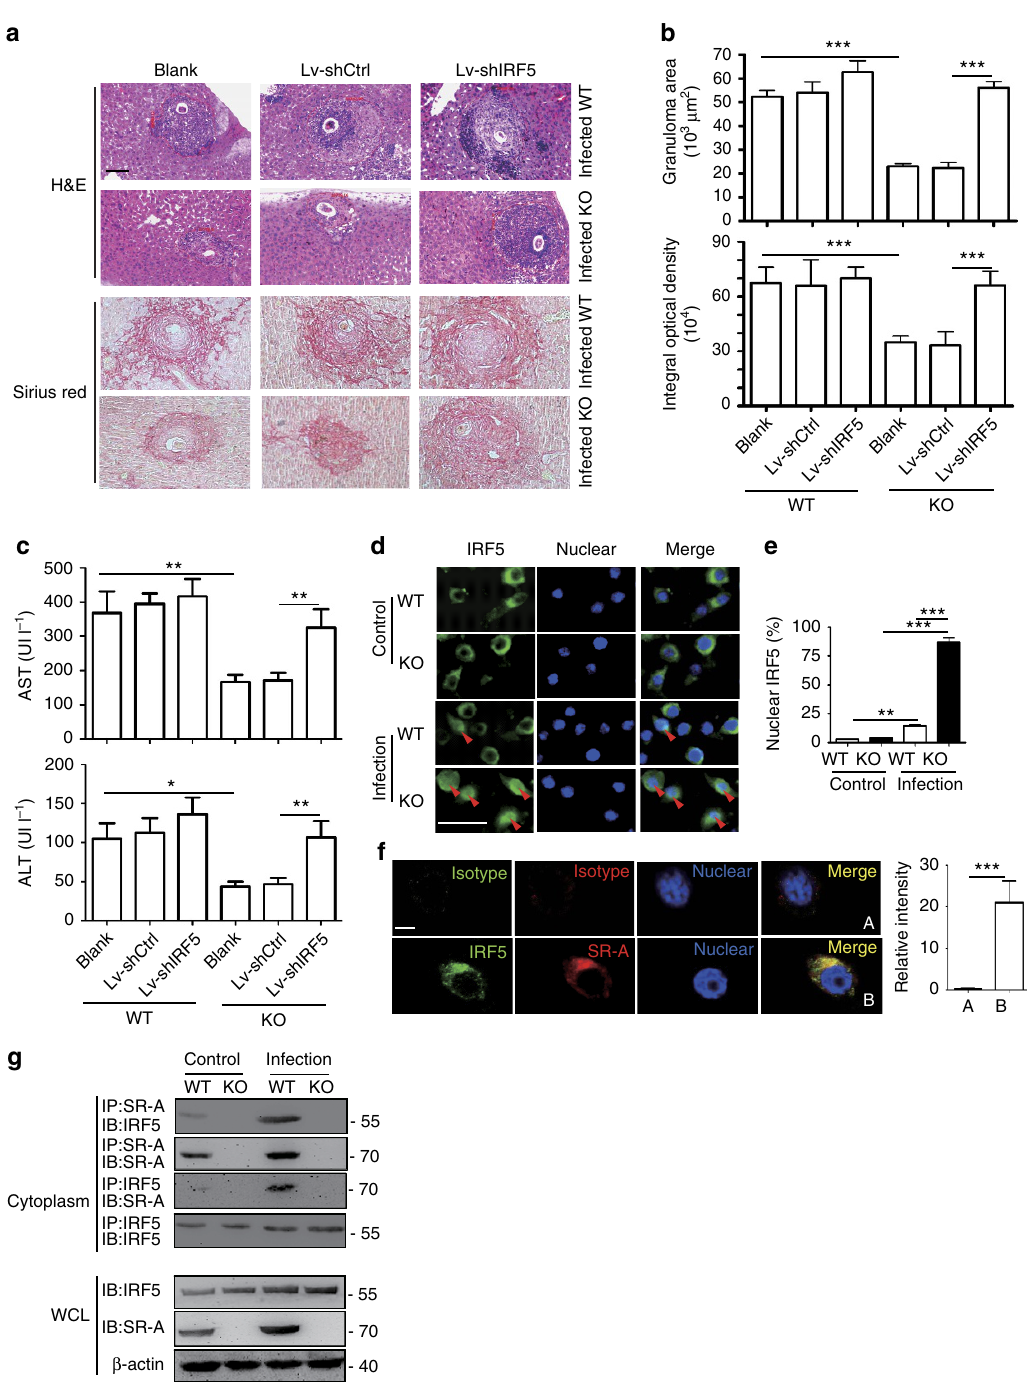
Figure 6 | SR-A/IRF5 interaction promotes liver pathology by regulation of M2/Th2 polarization. ( a – c ) Mice were i.v. injected with shRNA lentiviral particles targeting IRF5 since 3.5 weeks post S. japonicum infection by weekly for 4 weeks and killed at 7.5 weeks post S. japonicum infection for further study. ( a , b ) Granulomas and fibrosis in mouse livers from S. japonicum -infected WTor SR-A-deficient mice after Lv-shRNA injection. Scale bars, 100 m m. ( c ) Levels of serum ALT/ASTwere determined from S. japonicum -infected WTor SR-A-deficient mice after Lv-shRNA injection. Data are representative of two experiments with six mice per group in each experiment. *** P o 0.001, ** P o 0.01, * P o 0.05 (ANOVA/LSD). ( d ) Immunofluorescence of IRF5 (green) in the peritoneal macrophages from WTor SR-A-deficient mice infected with or without S. japonicum . Scale bars, 50 m m. ( e ) Quantification of nuclear IRF5 in the image above (from at least three fields of view with at least 100 cells per sample). ( f ) Co-localization of endogenous SR-A and IRF5 in RAW264.7 cells by confocal microscopy. Twenty macrophages were randomly selected for cell quantification of SR-A/IRF5 co-localization. For isotype control, 10 macrophages were randomly selected. Scale bars, 10 m m. Relative intensity ¼ intensity of the object (cell) (cid:2) intensity of the background, quantification of fluorescence in single macrophages of SR-A and IRF5 was achieved by ImageJ software. *** P o 0.001. Mean ± s.d. ( g ) Immunoblot analysis of IRF5 of endogenous SR-A immunoprecipitated from cytoplasmic protein extracted from peritoneal macrophages of WT or SR-A-deficient mice infected with or without S. japonicum . The association of SR-A and IRF5 was confirmed by a reciprocal immunoprecipitation assay using anti-IRF5. Immunoblot was also carried out using whole cell lysate